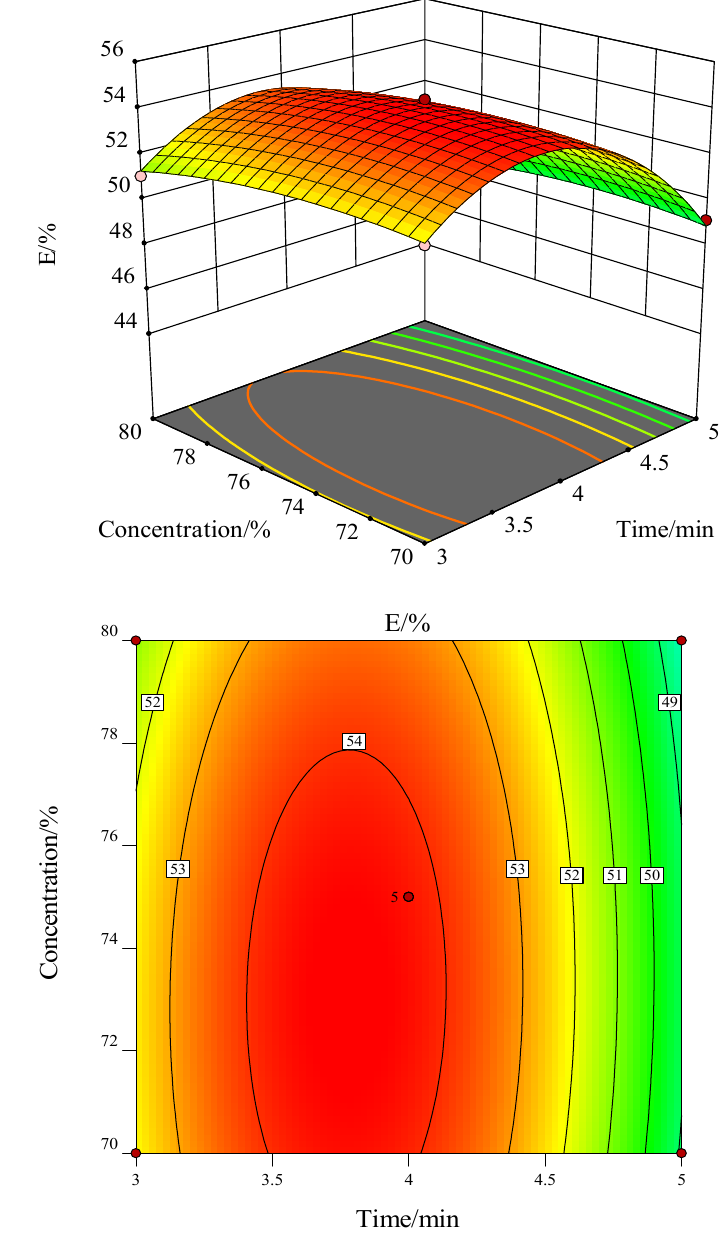
Figure 12. Response surface diagram and contour map at the action of grinding time and grinding concentration.